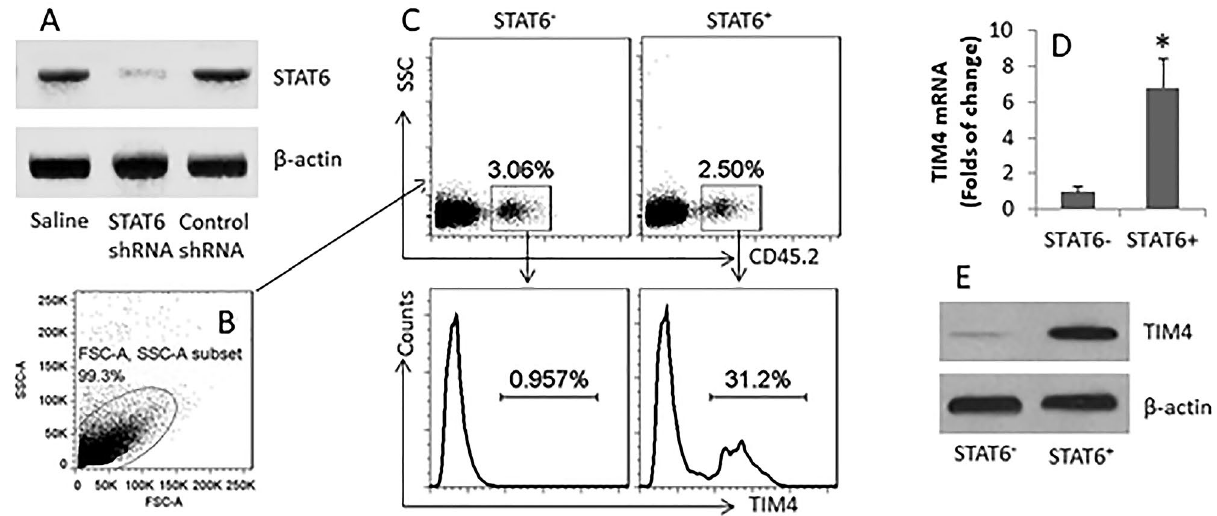
Figure 1. BMDCs were prepared from CD45.2 mice. STAT6 was knocked down in the CD45.2 + DCs ( A ). The STAT6 + and STAT6 − CD45 + DCs were adoptively transferred to CD45.1 mice; the mice were gavage-fed with CT (10 μg/mouse) daily for 4 days. LPMCs were prepared and analyzed by flow cytometry. ( B ) The gated dot plots show the cell population analyzed. ( C ) The gated dot plots show the CD45.2 + DCs in the LPMCs. The histograms show the frequency of TIM4 + CD45.2 + DCs. ( D – E ) The CD45.2 + DCs were isolated from LPMCs by MACS and analyzed by RT-qPCR and Western blotting. ( D ) The bars indicate the TIM4 mRNA levels (Mean ± SD; *p < 0.01, compared with the STAT6 − group) in the DC extracts. E, the blots indicate the TIM4 protein levels in the DC extracts. Each group consists of 6 mice. Samples from individual mice were analyzed separately. (Data from the DCs treated with control shRNA showed comparable levels of TIM4 in the naive CD45.2 + DCs; not